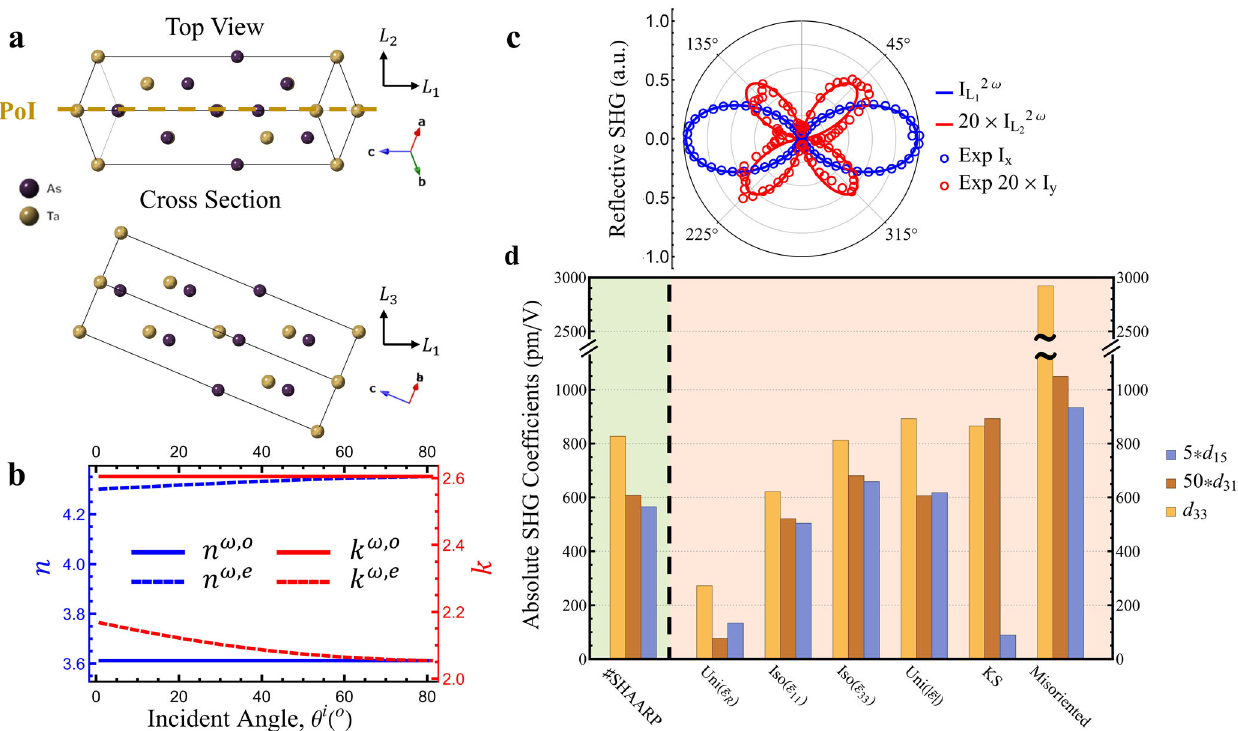
Fig. 7 Linear and nonlinear optical responses of TaAs (112). a Crystal structure and experimental orientation. b The effective complex refractive indices at ω frequency as a function of incident angle ( θ i ). c p - and s -polarized second harmonic responses as a function of azimuthal angle ( φ ) at various incident angles ( θ i ). d Comparison of the correct ratios of nonlinear coef fi cients (pale green background) as against other forced approximations (pale orange background). Uni, Iso, and KS, respectively, represent uniaxial, isotropic symmetry, and Kleinman ’ s symmetry approximations. Iso ð ε ii Þ indicates that the component ε ii was assumed in all directions under the isotropic approximation, where i is the direction index. Uni( ~ ε j j ) and Uni( ~ ε R ), respectively, mean using the magnitudes of complex relative dielectric permittivity and only the real part of the dielectric permittivity as tensor values while retaining the uniaxial dielectric permittivity tensor symmetry. Misoriented case represents analysis using the plane normal as [112] which is discussed in detail in Supplementary Note